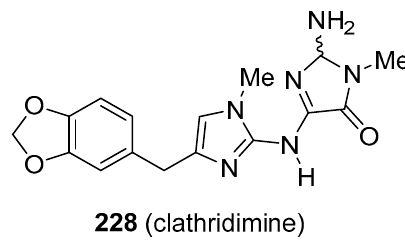
Figure 10. Structure of clathridimine ( 228 ).